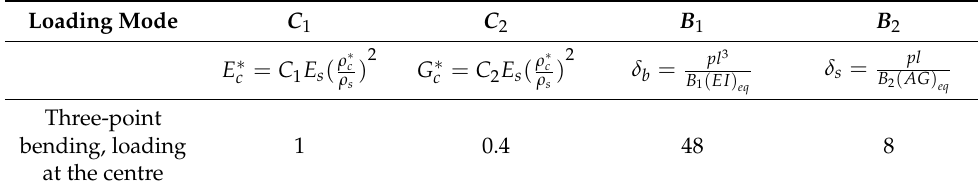
Table 1. Constants for the three-point bending testing [3].